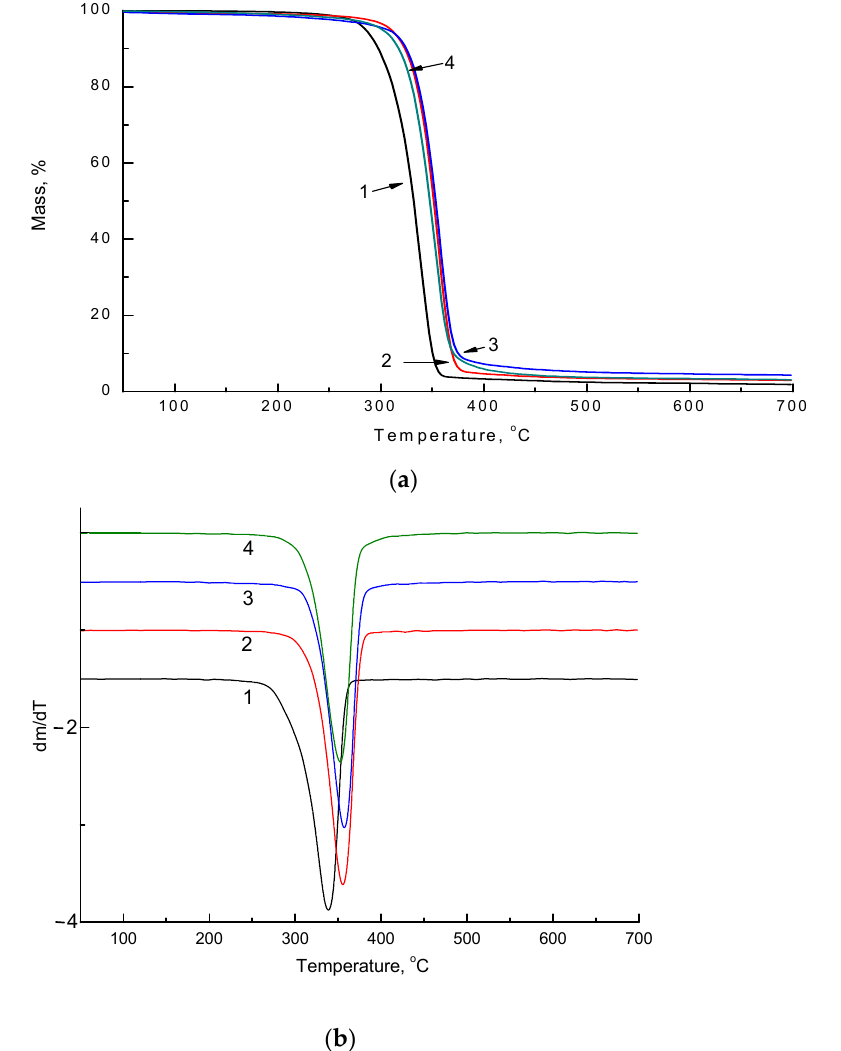
Figure 9. TGA ( a ) and DTG ( b ) thermograms after degradation in the soil during 220 days of PLA/NR samples with different NR content wt.%: 0 (1), 5 (2), 10 (3), 15 (4).